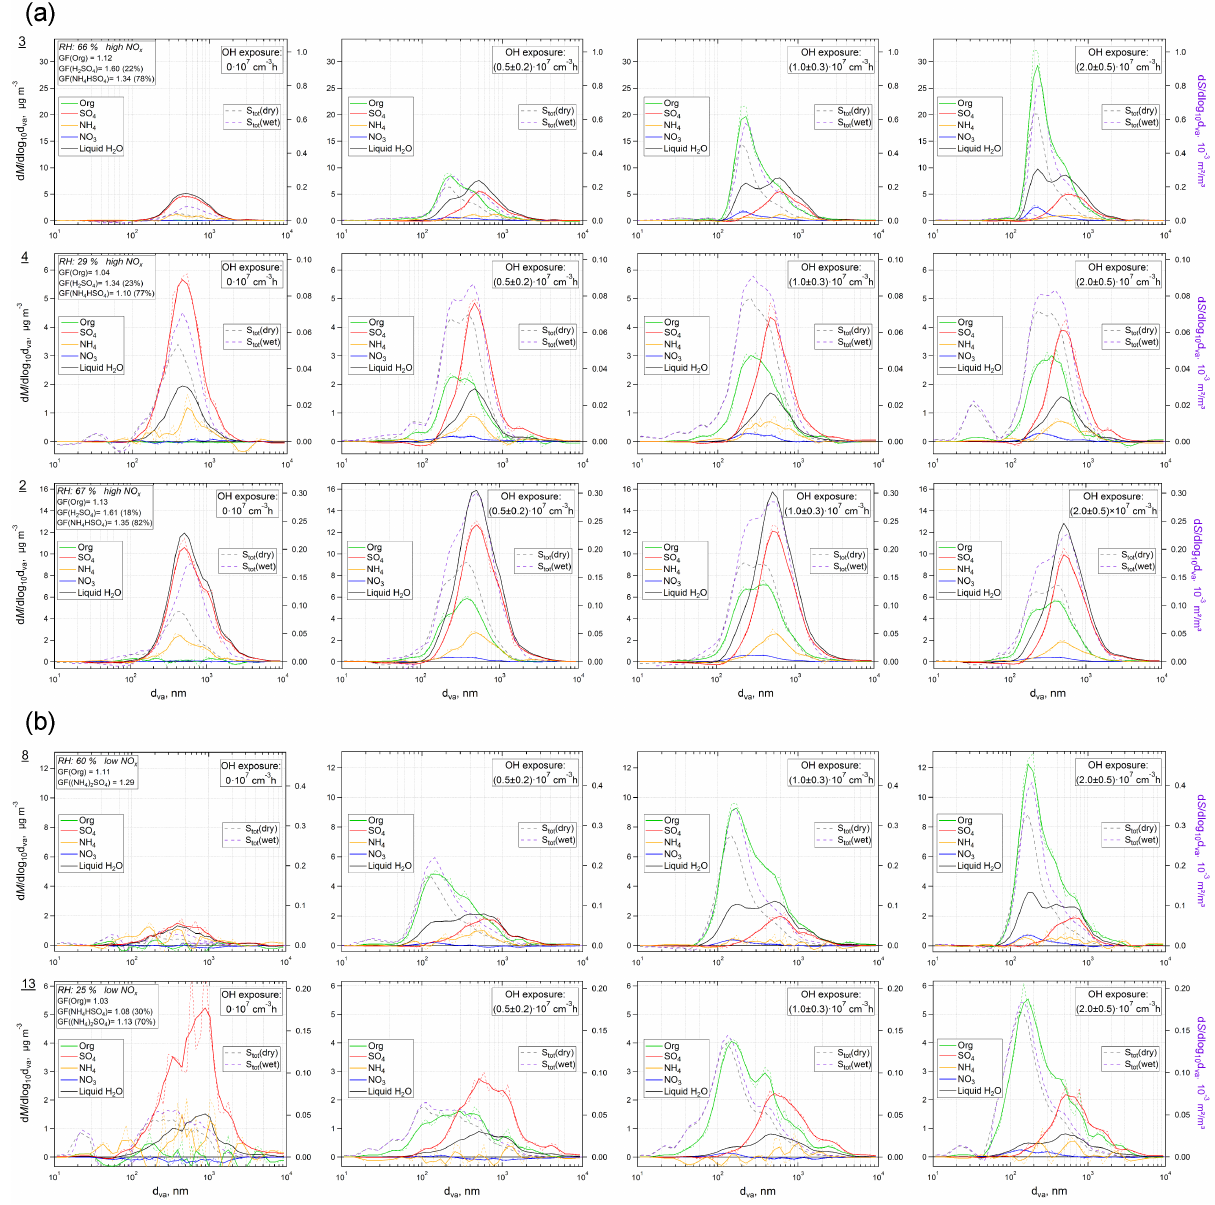
Figure 4. Evolution of size distributions from the HR-ToF-AMS. Measured organic, SO 4 , NH 4 , and NO 3 mass distributions for OH expo- sures of 0 × , (0.5 ± 0.2) × , (1.0 ± 0.3) × and (2.0 ± 0.5) × 10 7 cm − 3 h. Black lines represent estimated liquid water content (method: Sect. 2.3; RH and individual GFs given in the legend, percentage in brackets: fractions of SO 4 ) . The calculated dry and wet surface distributions are shown as dashed lines on the right axes. (a) High NO x with more acidic seed [H 2 SO 4 and NH 4 HSO 4 ]: experiments 3 and 4 with NO x /α - pinene = 1.2 and experiment 2 with NO x /α -pinene = 3.8. (b) Low NO x with less acidic seed [(NH 4 ) 2 SO 4 and NH 4 HSO 4 ]: experiments 8 and 13 with NO x /α -pinene ≈ 0.05. Additional figures in the Supplement (Fig.